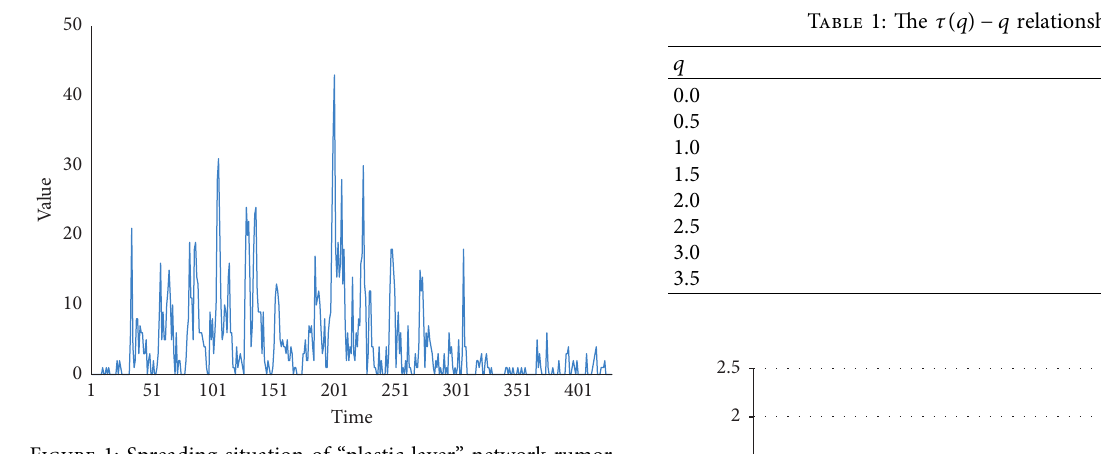
Figure 1: Spreading situation of “plastic laver” network rumor.